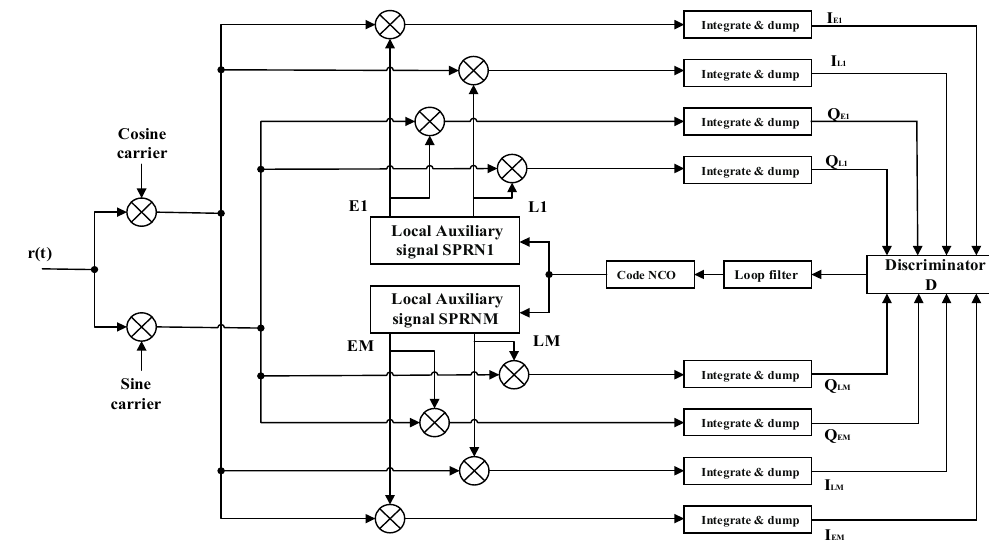
Figure 18. The proposed code tracking loop.